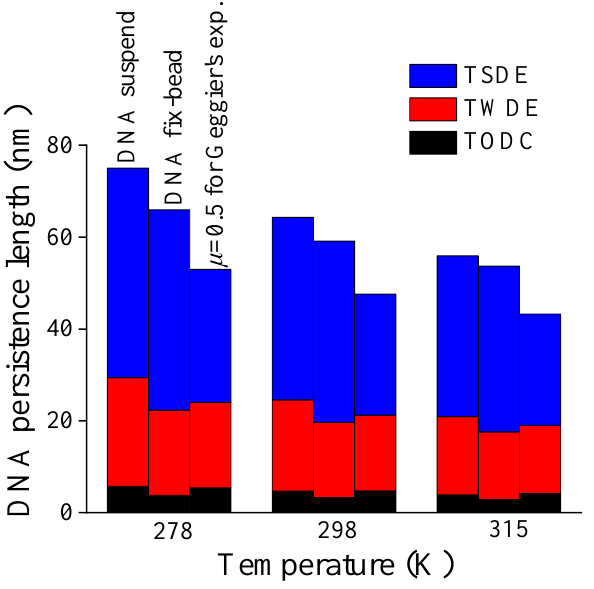
Figure 7. Contributions of three additive terms (TODC, TWDE, TSDE) to DNA persistence length versus temperature.